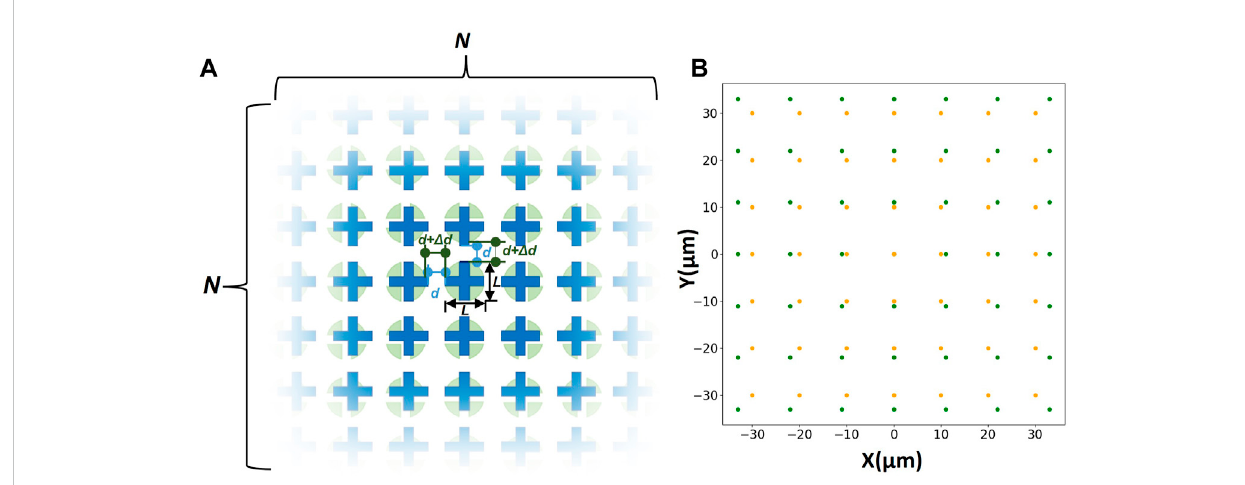
FIGURE 1 (A) Schematic diagram of the two-layers matrix structure. The blue layer with N x N crisscross micropatterns is the upper layer, and the green layer with N x N circles is the lower layer. (B) The coordinate diagram of the matrix (N = 7 μ m, L = 5 μ m, d = 5 μ m, Δ d = 1